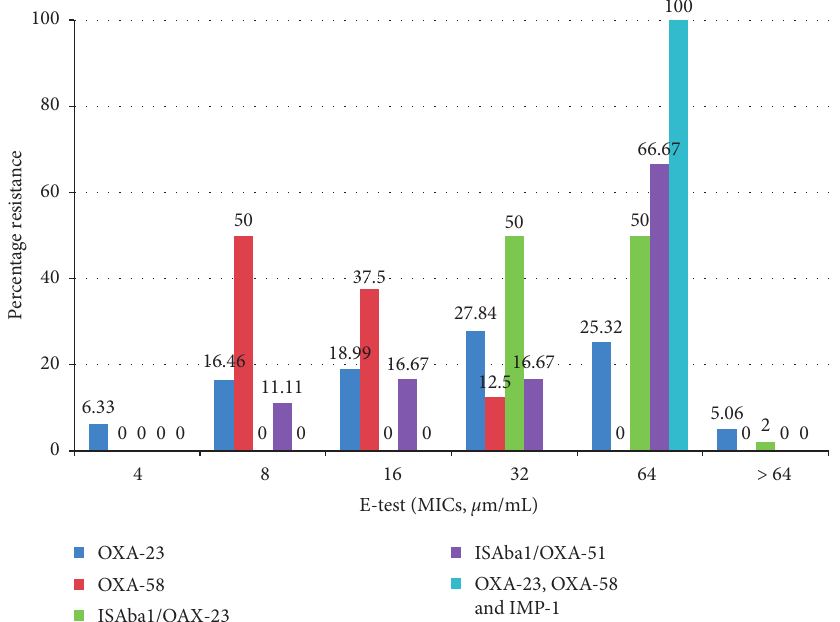
Figure 3: Distribution of meropenem MICs in 100 CRAB isolates with the bla bla OXA-51-like and bla OXA-23-like , bla OXA-58-like and bla IMP-1